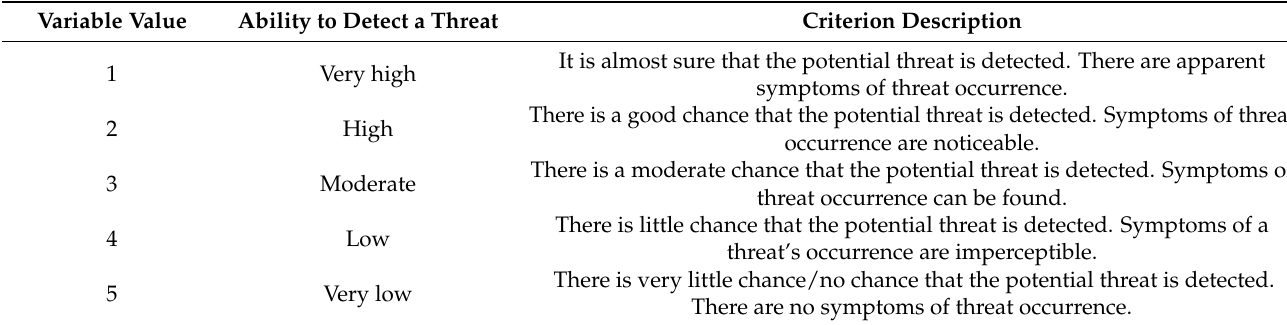
Table 2. Criteria for variable 3—the ability to detect a threat, own